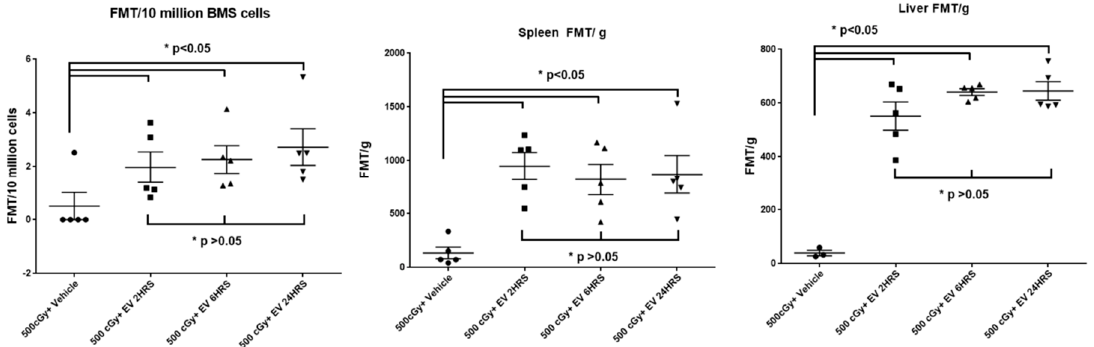
Figure 7. The fluorescence signals in the liver, spleen, and bone marrow from 500 cGy radiation exposed mice at 2, 6, and 24 h post-systemically administrated EVs. The intensity of fluorescence is expressed as the average of fluorescence intensity (count / energy) / weight of tissue or 10 million bone marrow cells ± SEM, n = 5 / group. The results were analyzed by one-way ANOVA with a multi-comparison test, * p < 0.05 EV treated groups compared to vehicle control group.